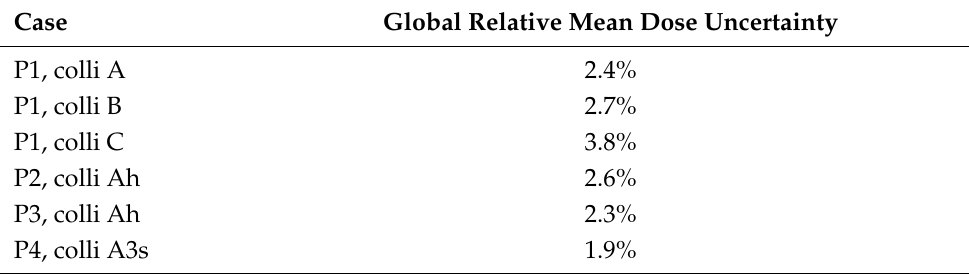
Figure 5. Regions of the dose distributions used for global uncertainty calculation. Only the voxels inside the regions delineated by the yellow dashed lines were considered. Table 2. Global relative mean dose uncertainties for the different cases.